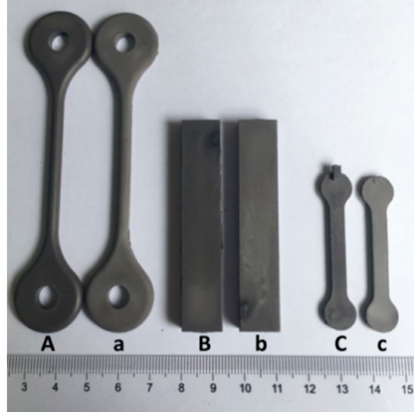
Figure 2. Demonstration of green parts (samples A – C ) and solvent-debinded parts (samples a – c